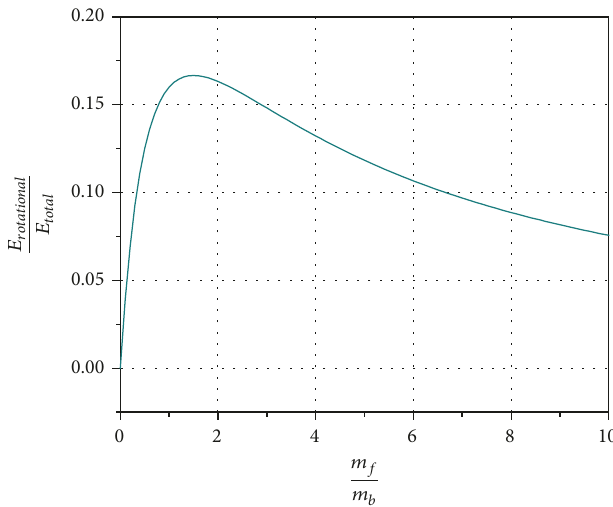
Figure 4: Ratio of rotational energy to total energy input: without considering the coefficient of restitution.